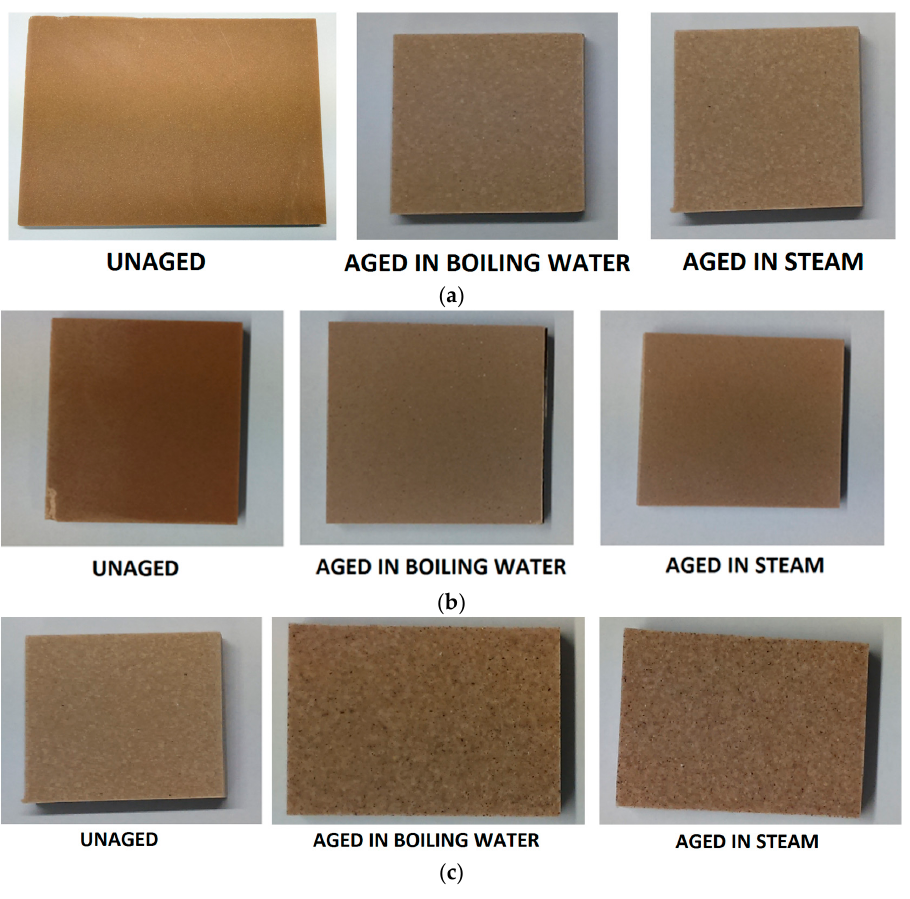
Table 3. Colour change due to UV